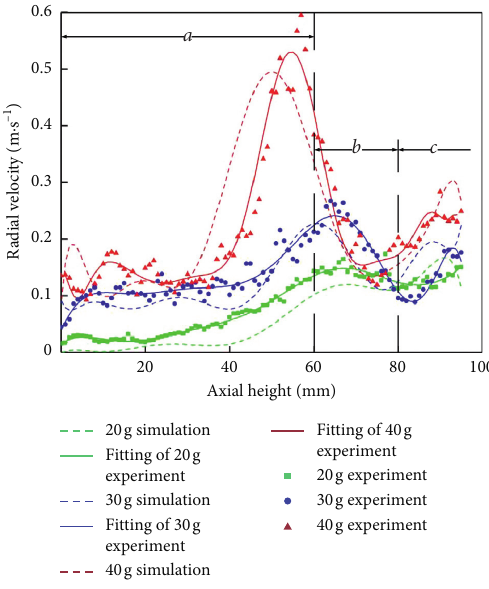
Figure 5: Simulations and experiments of radial velocity in gas- liquid-solid